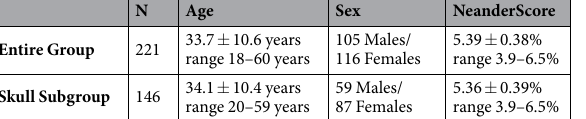
Table 1. Subject demographics for the entire group and subset of subjects used in the skull shape analysis, mean ±